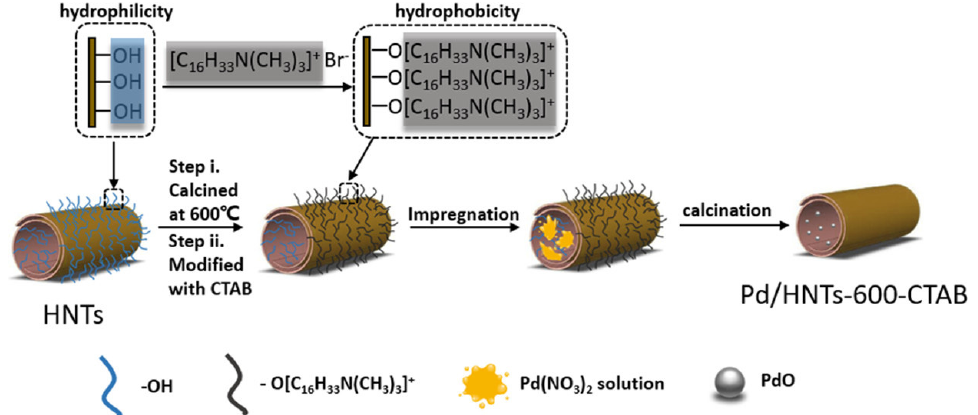
Figure 15. Schematic representation of the HNTs external surface hydrophobization to the selective loading of Pd inside the HNTs lumen. Reproduced with permission from ref. [120]. Copyright 2020 American Chemical Society.